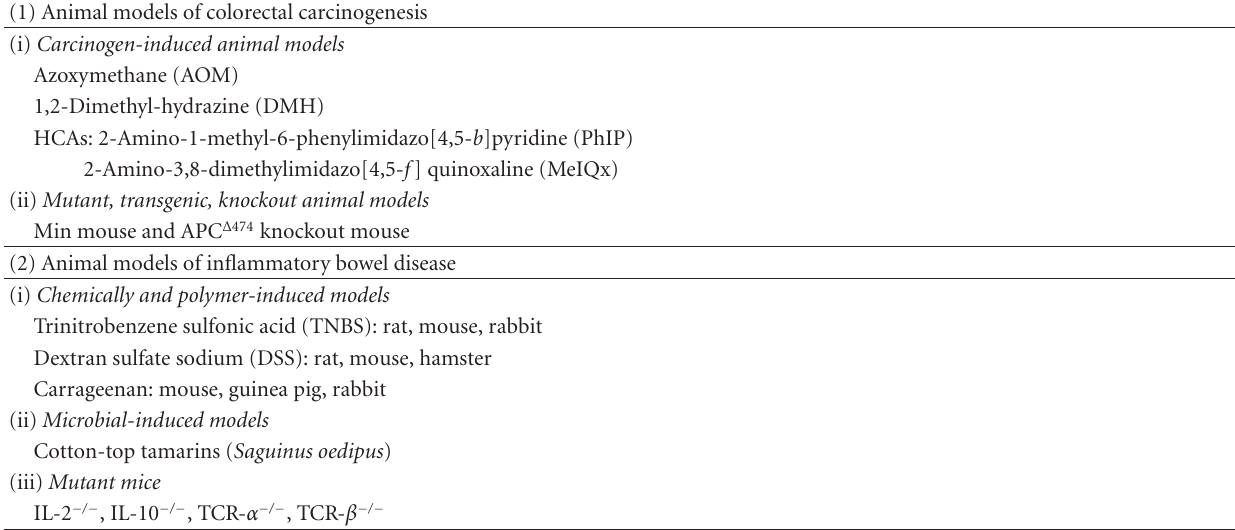
Figure 10: Experimental protocol of time-course observation of AOM/DSS-induce inflammation-associated colorectal carcinogenesis and tumor development (incidence and multiplicity) during the study [11]. Table 2: Animal models of colorectal carcinogenesis and inflammatory bowel disease. HCAs: heterocyclic amines. (1) Animal models of colorectal